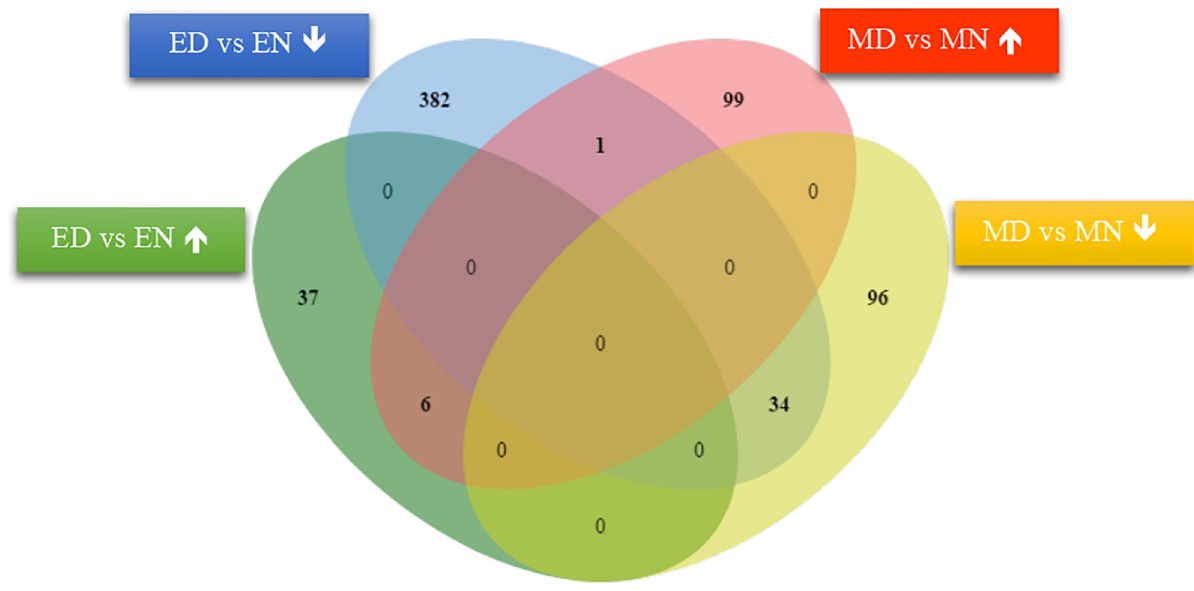
Fig 2. The number of DEGs ( � 2-fold change; p � 0.01) showing overlapping and specific response under various experimental conditions in drought. ED, L-82 under drought and EN, L-82 under normal conditions. MD, Marvdasht under drought and MN, Marvdasht under normal conditions. " and # , up and down-regulated